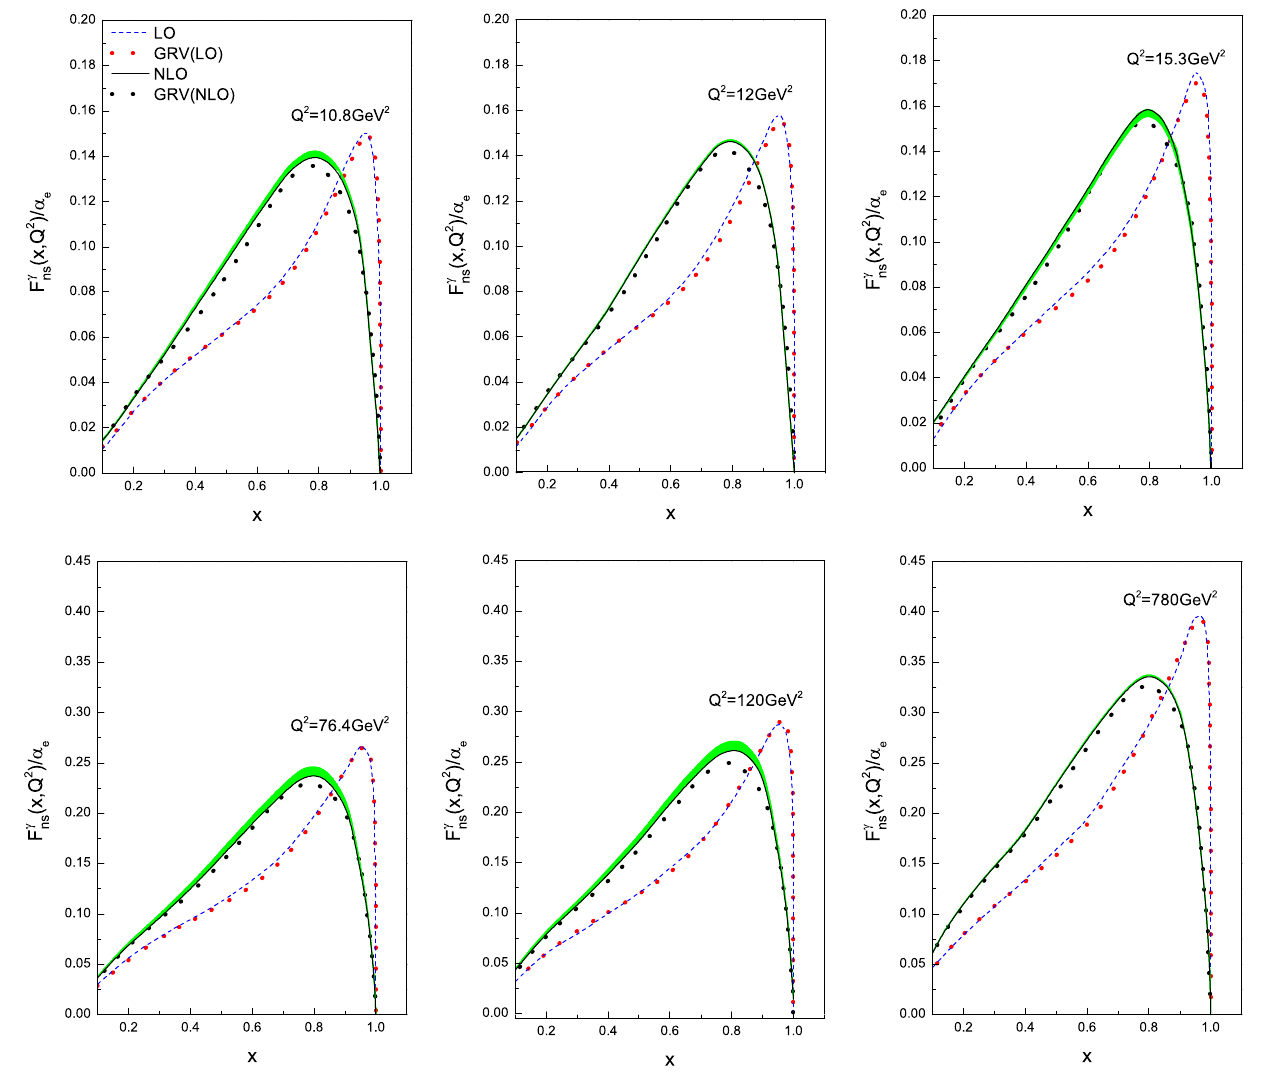
γ ns of the photon at LO and NLO with the GRV results